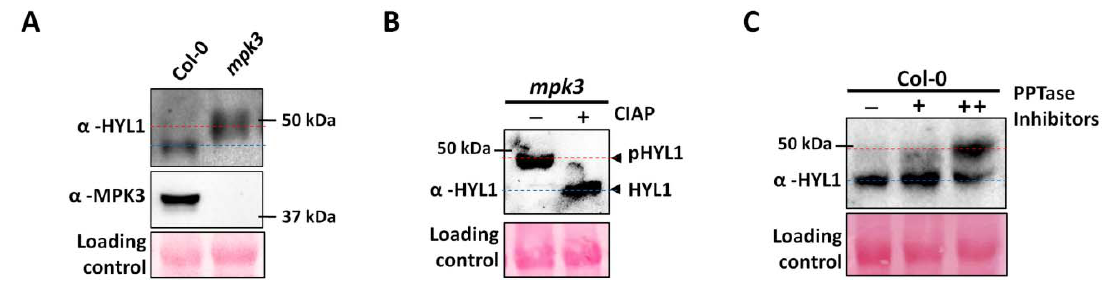
Figure 3. MPK3 is a negative regulator of HYL1 protein abundance. ( A ) mpk3 mutants accumulate hyper-phosphorylated HYL1. Total proteins were extracted from 12 day-old Col-0 and mpk3 seedlings and used for the detection of HYL1 proteins by anti-HYL1, while MPK3 was detected by anti-MPK3 antibody. The red dotted line represents the slow migrating HYL1 band. ( B ) The total protein extracted from the mpk3 seedlings was incubated with (+) or without (-) calf intestinal alkaline phosphatase (CIAP) and further used for the detection of the HYL1 protein. The blue dotted line represents the dephosphorylated HYL1. The plus and minus signs indicate the presence and absence of CIAP. ( C ) A Western blot showing the accumulation of hyper-phosphorylated HYL1 protein in seedlings treated with or without (+/ − ) protein phosphatase (PPTase) inhibitors. ++ in- dicates double concentration of PPTase. 2.4. AtMPK3 Promotes AtHYL1 Protein Degradation Previous reports suggest that phosphorylation status at S-42 does not affect AtHYL1 stability; rather, it inhibits the interaction with pri-miRNAs and the stability of AtHYL1 is enhanced by phosphorylation at S-159 by unknown kinases [16]. To find out if AtHYL1 phosphorylation at S-42 by AtMPK3 affects its stability, we treated Col-0 seedlings with MAPK inhibitors overnight, and then subjected them to immunoblotting. We found that the inhibitor treatment enhanced AtHYL1 protein accumulation as compared to the un- treated samples, suggesting that phosphorylation by MAPK regulates its protein stability (Figure 4A). The result indicates that a higher AtHYL1 protein stability in the mpk3 mu- tant (Figure 3) is due to a lack of AtMPK3-induced phosphorylation in the protein.